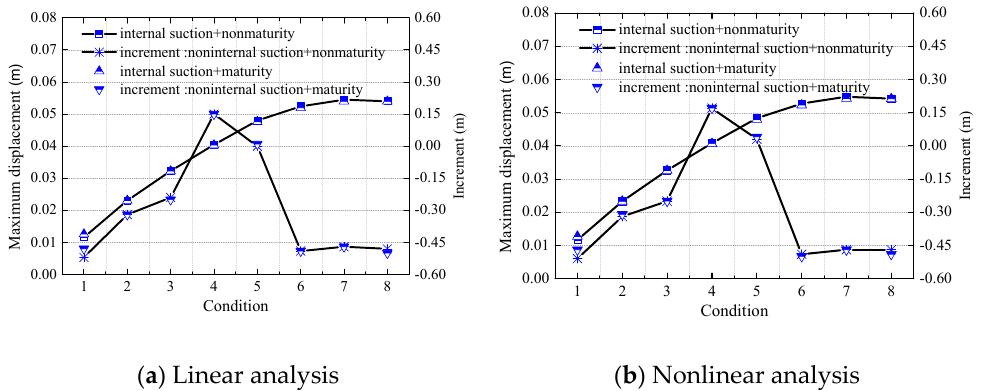
Figure 17. Comparison of maximum displacement in linear and non-linear analyses under basic wind speed.